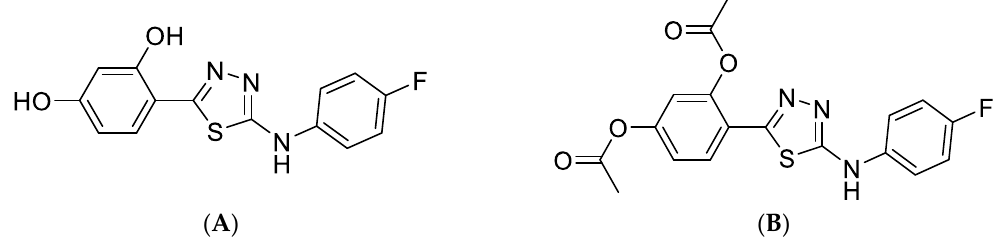
Scheme 1. The chemical structure of compounds: ( A ) 2-((4-fluorophenyl)amino)-5-(2,4- dihydroxybenzeno)-1,3,4-thiadiazole (FABT); ( B ) 2-acetamido-5-((phenyl-2,4-diacetate)-yl)-1,3,4- thiadiazole